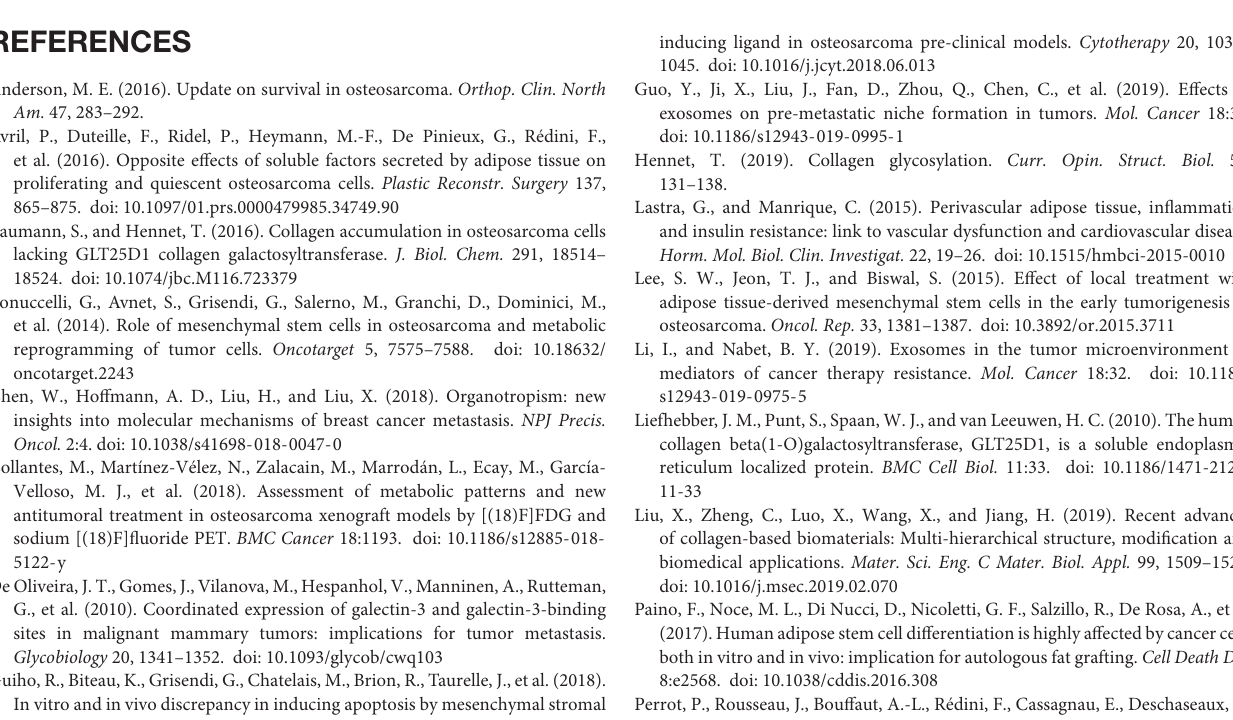
FIGURE S2 | COLGALT2 mRNA expression in ADSCs and MRC-5 cells exosomes were examined by qRT-PCR